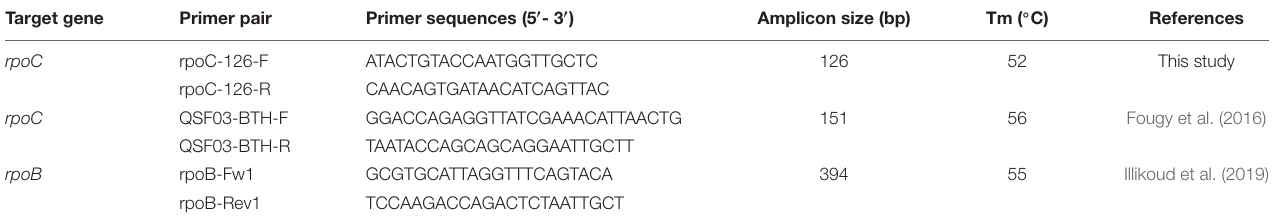
TABLE 2 | Description of the three sets of qPCR